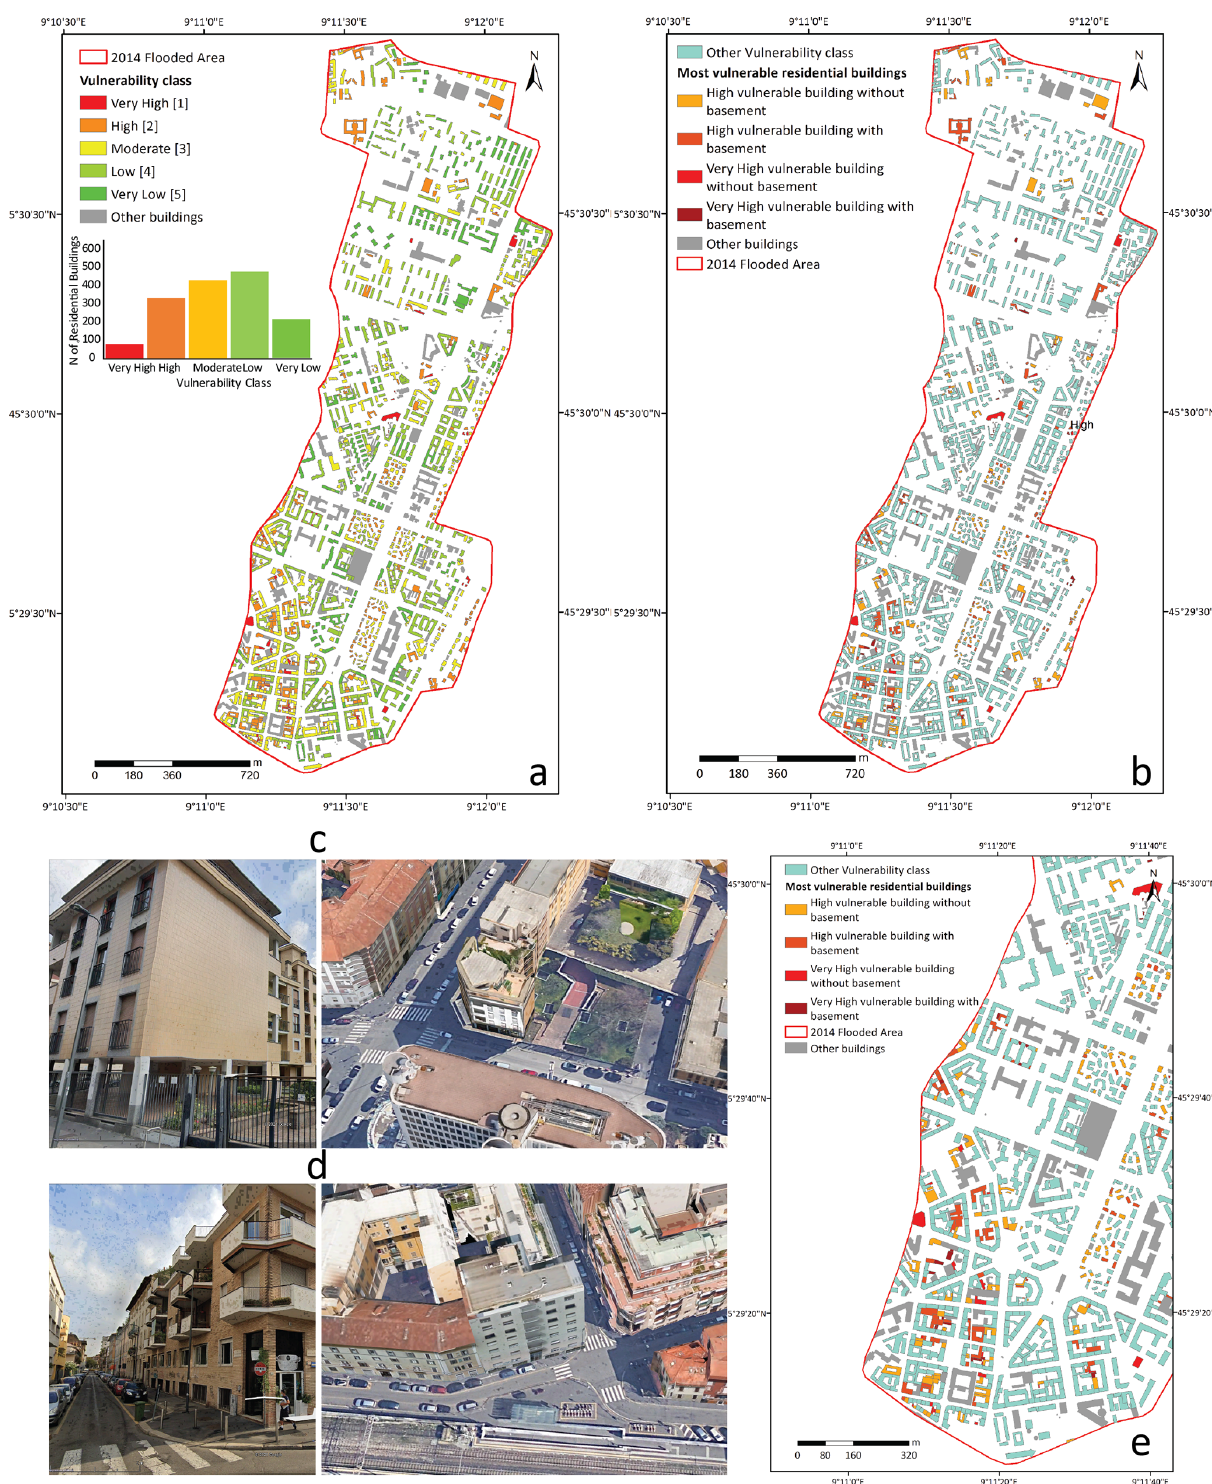
Figure 7. (a) Residential building maps classified by vulnerability class and frequency; (b) the most vulnerable residential buildings with and without a basement map; examples of residential buildings falling in classes high and very high (c) without a basement and (d) with a basement respectively and (e) their location. Built-up-area shapefile is from © OpenStreetMap contributors 2022. Distributed under the Open Data Commons Open Database License (ODbL) v1.0. Building pictures are from © Google Maps